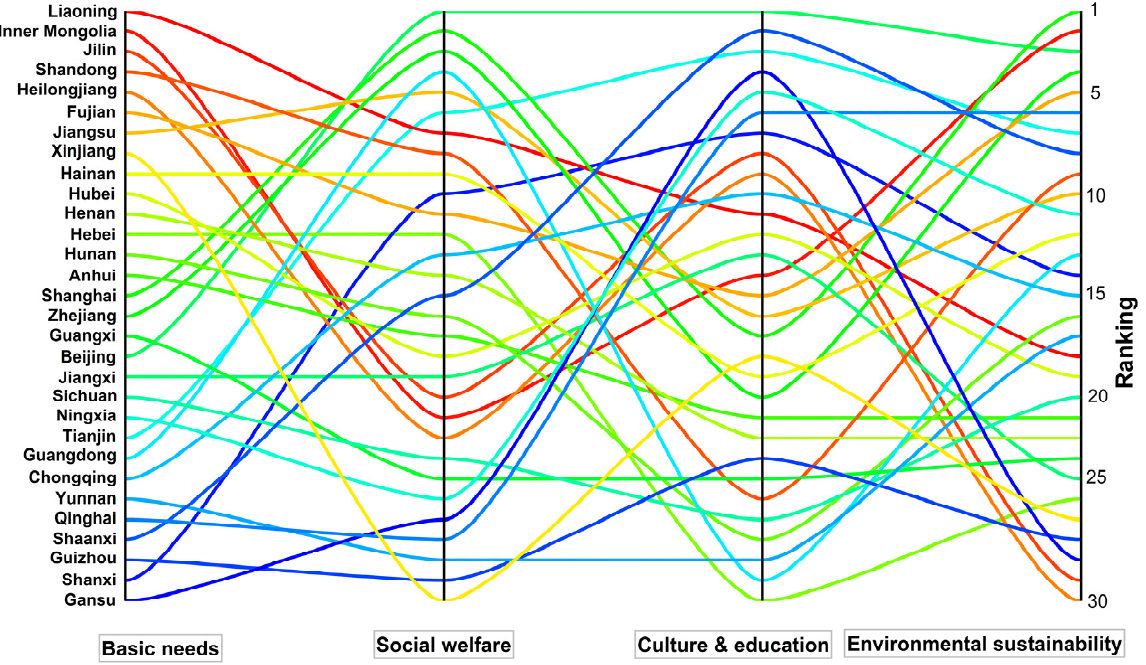
Figure 3. Rankings of subsystem scores of 30 provinces in 2020.